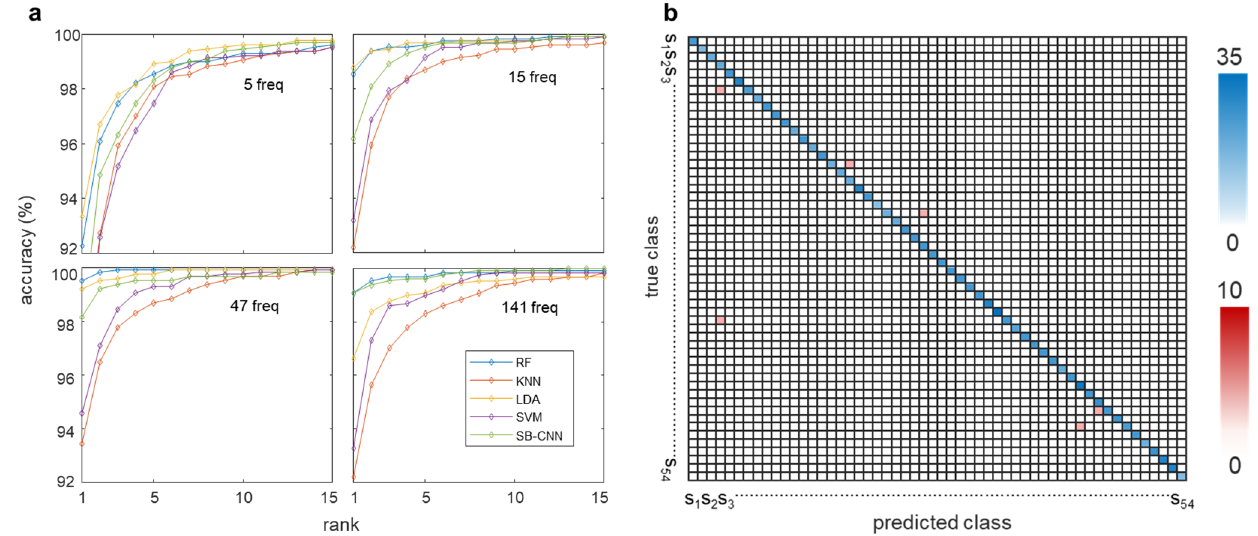
Figure 10. Individual identification accuracy of each classification model according to four different numbers of frequencies (5, 15, 47, and 141). ( a ) The cumulative matching characteristic (CMC) curves for the classifier models for each case of selected frequencies. ( b ) Confusion matrix of the RF classifier among 54 subjects in the case of 47 frequencies.